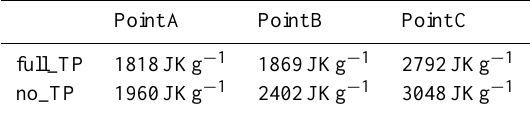
Table 1. Convective available potential energy (CAPE) for point A (80 ◦ E, 20 ◦ N), point B (80 ◦ E, 25 ◦ N), and point C (90 ◦ E, 25 ◦ N) over the northern Indian continent in the FULL_TP and NO_TP experiments. The locations of the three points are shown in Fig. 3.